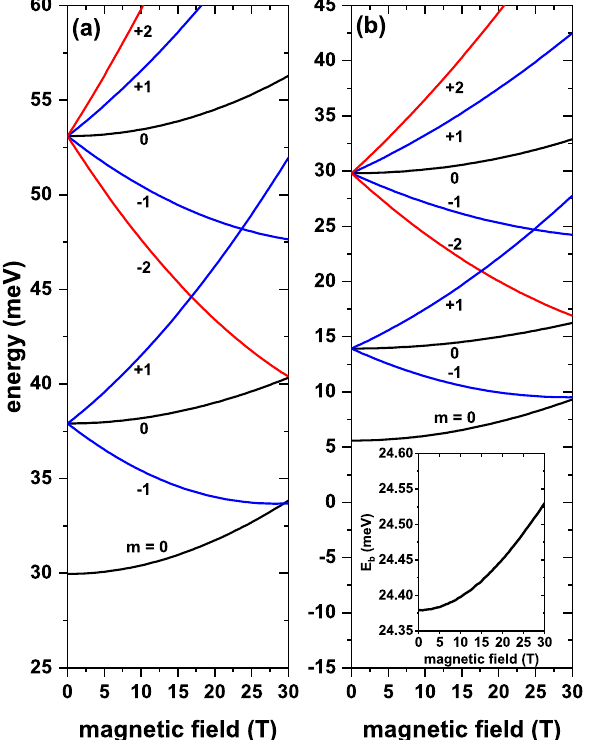
Figure 3. The lowest three electronic states in a ZnS/CdS/ZnS spherical core/shell/shell quantum dot as functions of the applied magnetic field. Plot ( a ) contains results without, and ( b ) includes on-center donor impurity effect, for R 1 = 4nm, R 2 = 11nm, and R 3 = 12nm. Different values of the m -quantum number and without external electric field effects have been considered. Labels close to the curves give the values of the m -quantum number. The inset in ( b ) corresponds to the ground state (lowest state with m = 0) binding energy as a function of the applied magnetic